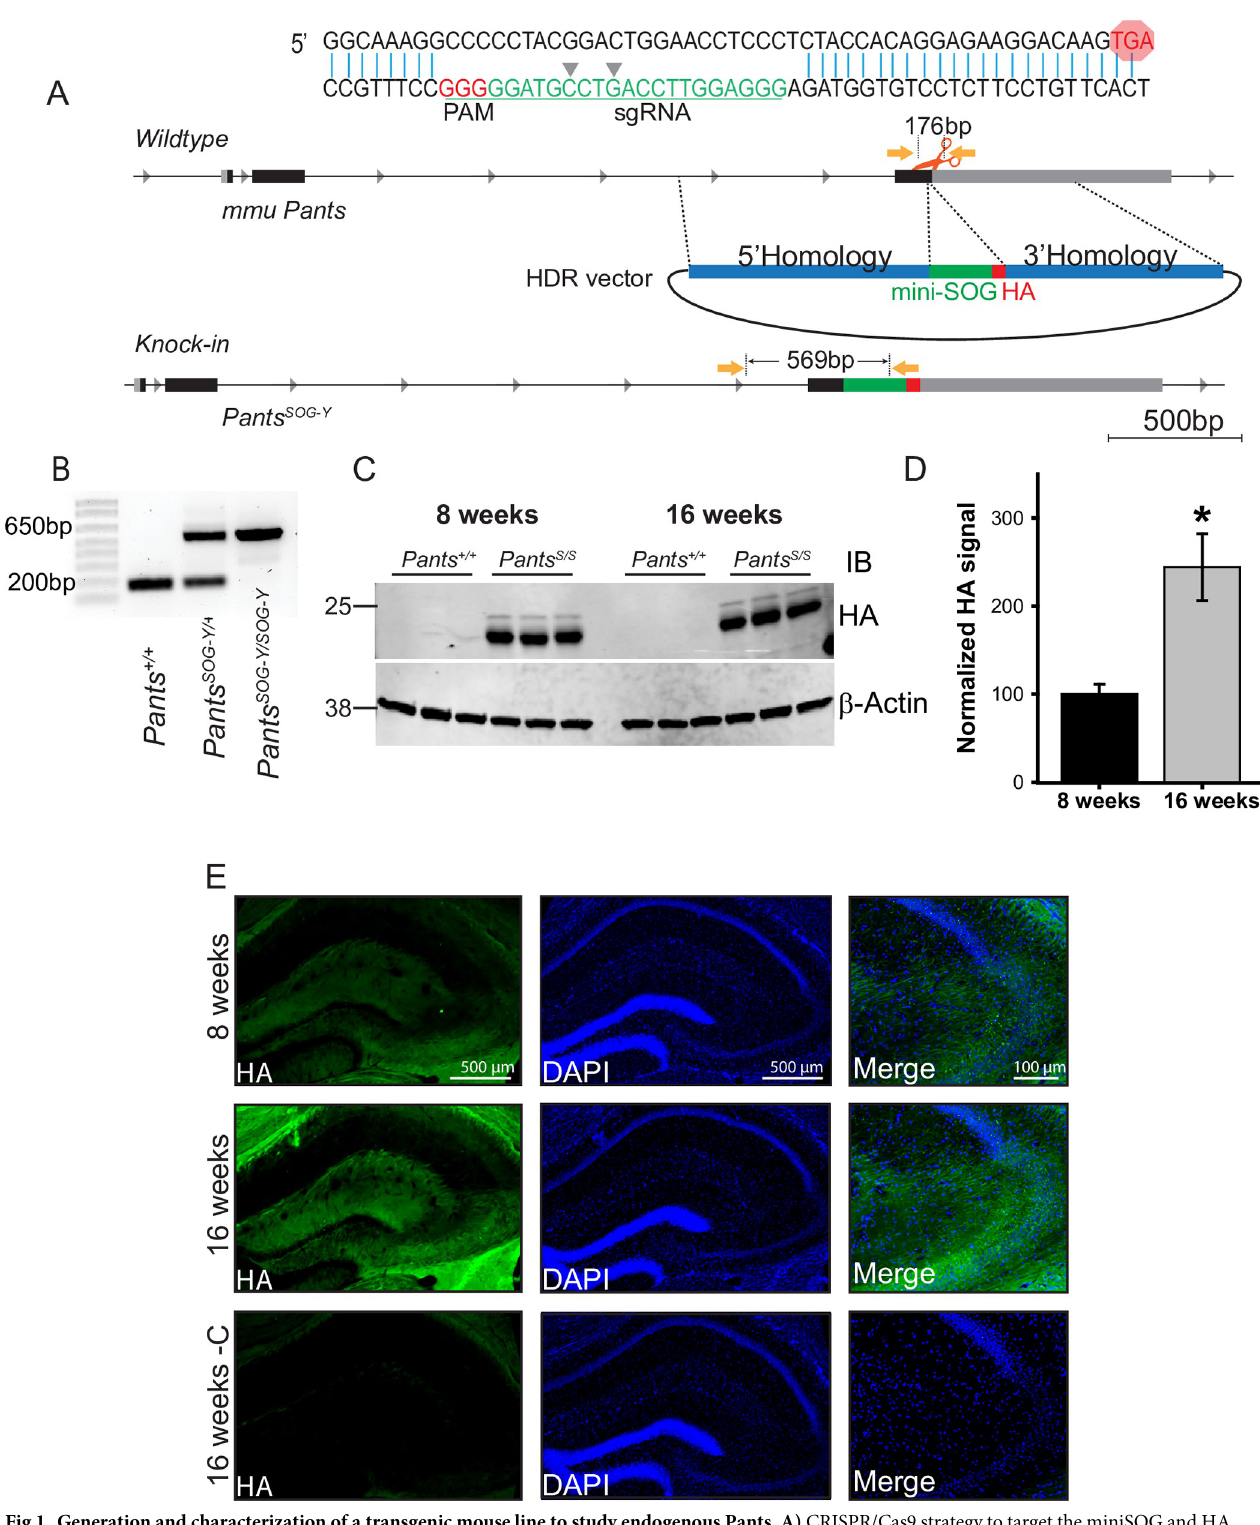
Fig 1. Generation and characterization of a transgenic mouse line to study endogenous Pants. A) CRISPR/Cas9 strategy to target the miniSOG and HA tags to the C-terminus of the endogenous Pants locus. B) Genotyping verification of insert in mouse tail biopsies. C) Quantitative Western blot of Pants immunoprecipitated from hippocampus of Pants SOG-Y and WT control mice at 8 and 16 weeks immunoblotted with HA antibody. D) Quantification of HA